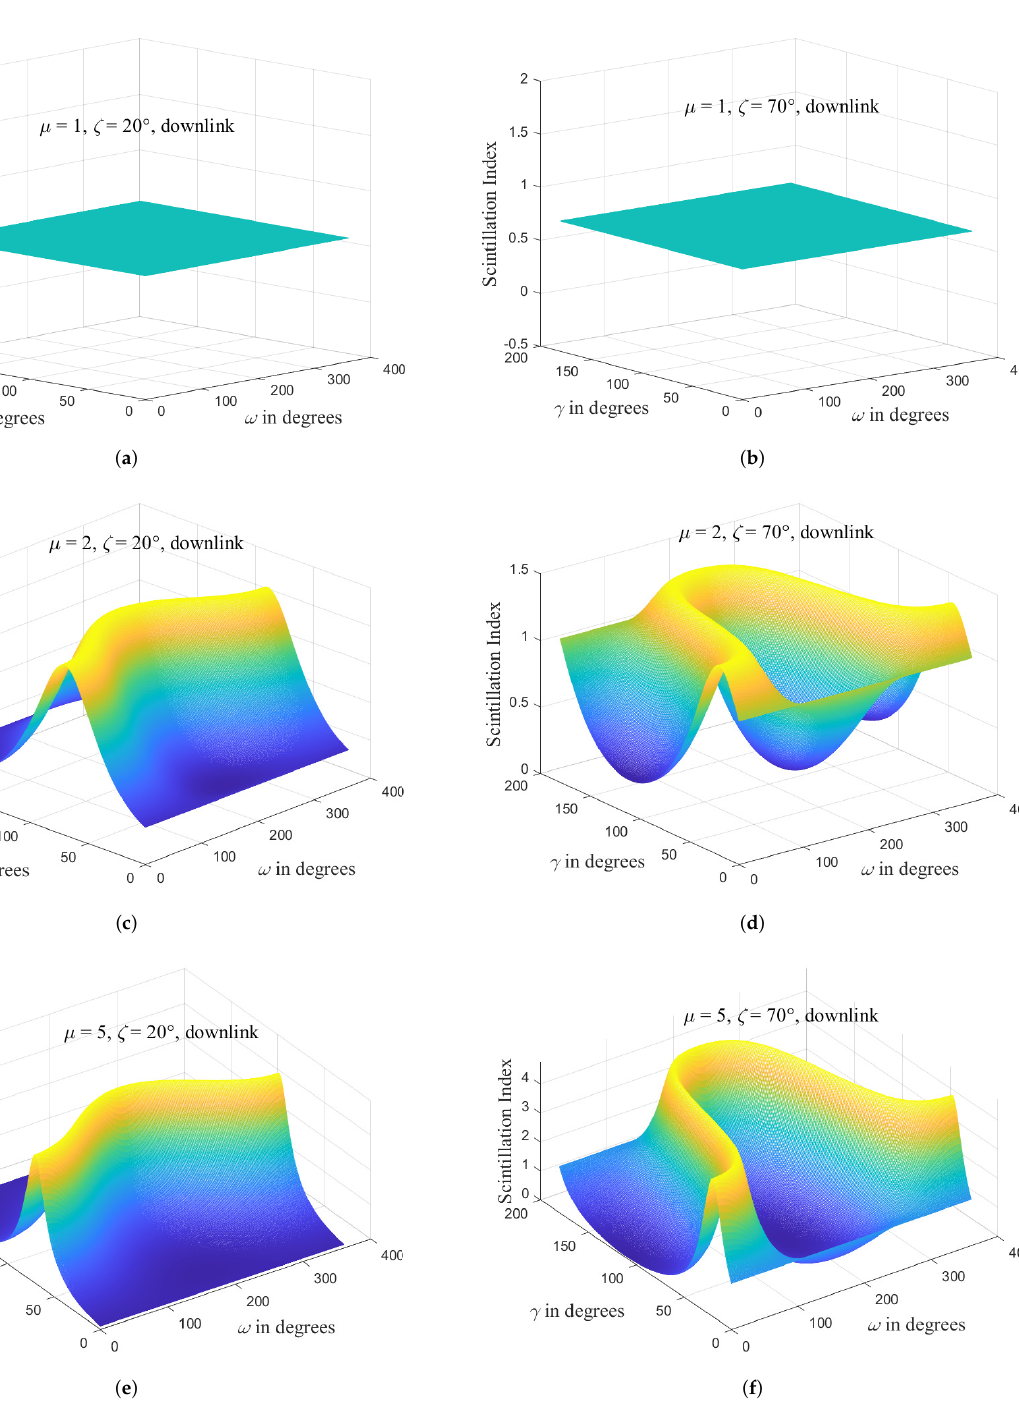
Figure 3. Scintillation index of downlink as the function of anisotropic tilt angle γ and azimuth angle ω for several values of zenith angle ζ and anisotropic factor µ , with ( a ) for µ = 1 and ζ = 20 ◦ , ( b ) for µ = 1 and ζ = 70 ◦ , ( c ) for µ = 2 and ζ = 20 ◦ , ( d ) for µ = 2 and ζ = 70 ◦ , ( e ) for µ = 5 and ζ = 20 ◦ , and ( f ) for µ = 5 and ζ = 70 ◦